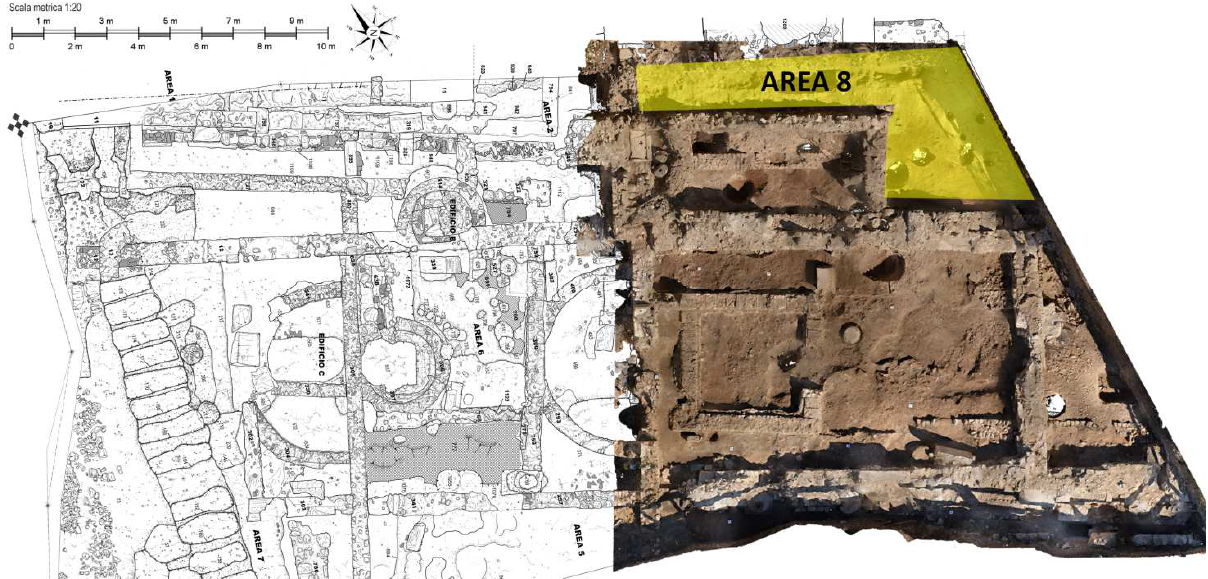
Figure 1. Planimetry of the excavation area with the overlapping of the orthophoto, exported by Photoscan, and the area 8 highlighted in yellow (Planimetry by A.